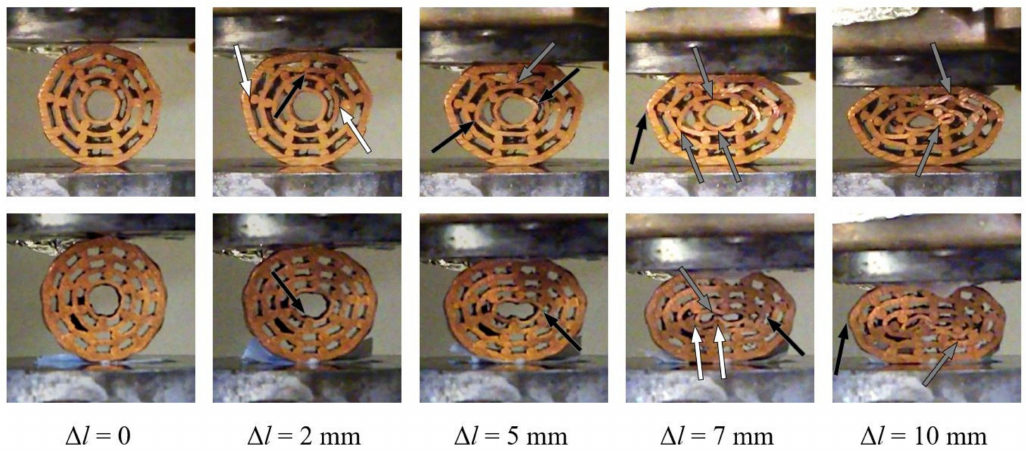
Figure 10. Deformation mechanism (white arrows denote debonding, black denote bending or buckling, and grey arrows denote contact) of the type 2 specimens (#2.1: upper row; #2.2: lower row).